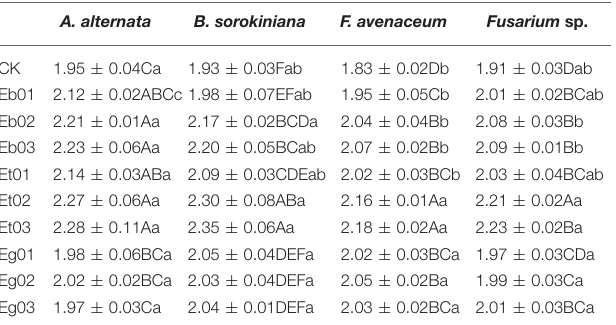
TABLE 5 | Dry weight (10 − 2 g) of Elymus sibiricus under seed-borne fungi stress resulting from effects of the Epichloë